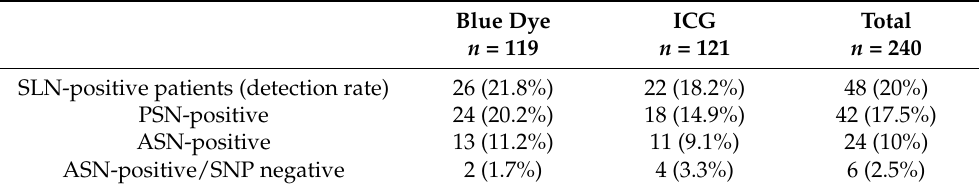
Table 3. Positive lymph nodes.